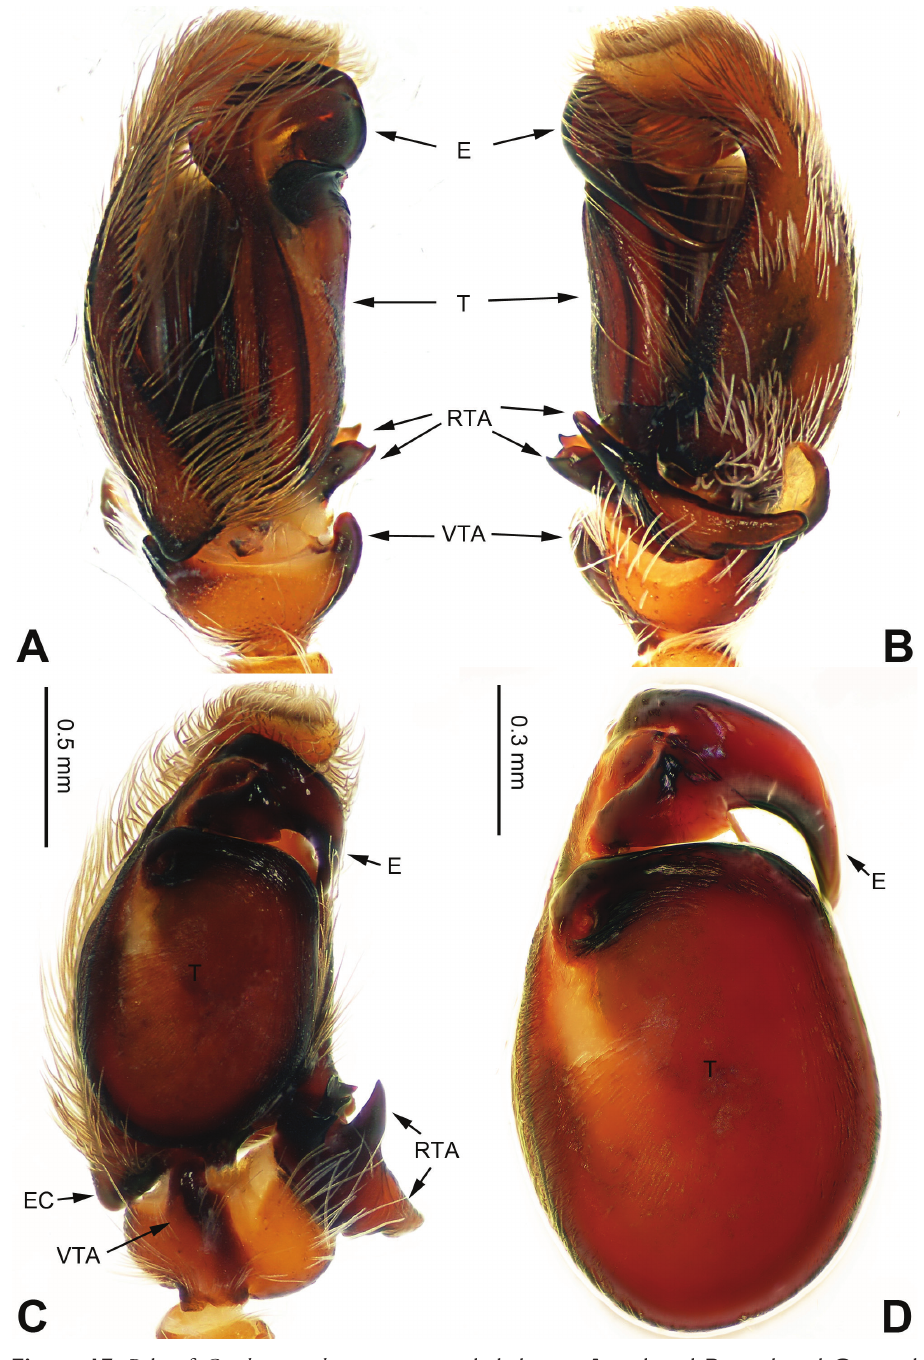
Figure 17. Palp of Cocalus menglaensis sp. n., male holotype. A prolateral B retrolateral C ventral D bulb, ventral. Scale bar equal for A–C